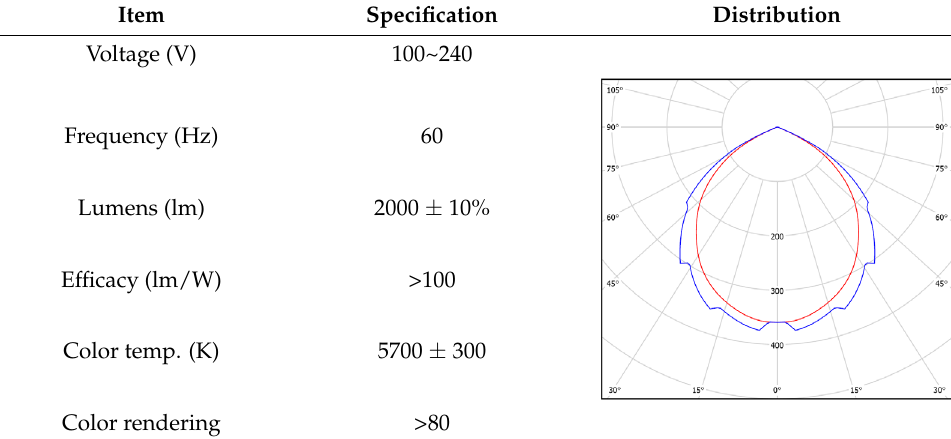
Table 4. Luminaires specifications of classroom EE-406.